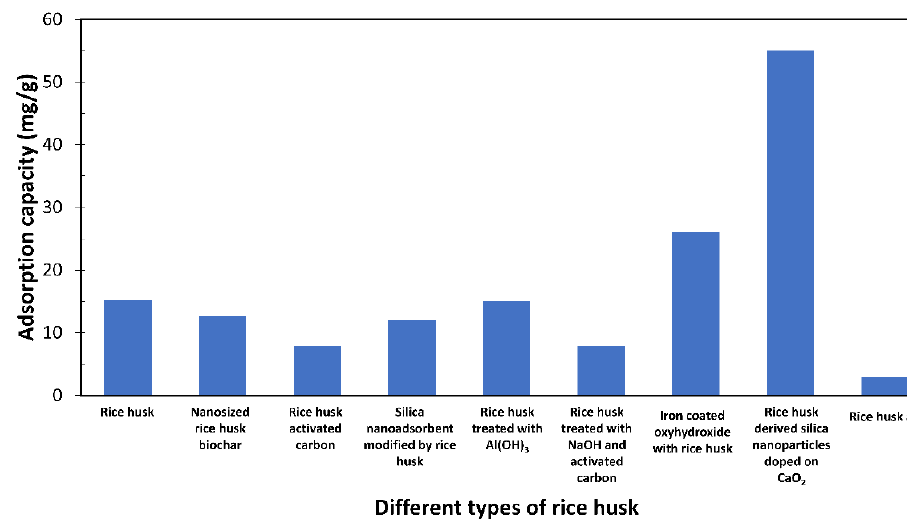
Figure 8. Adsorption capacities by different types of rice husk [78,100,101,104,106–109]. Table 8. Adsorption capacities of fluoride on different types of rice husk and rice husk